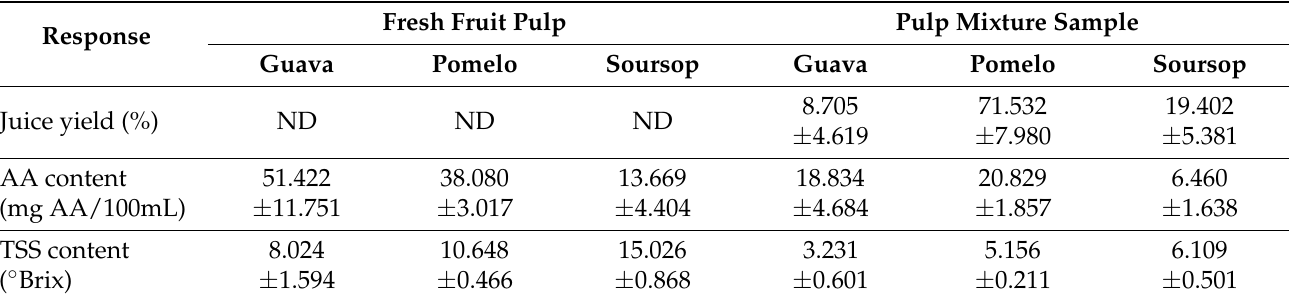
Table 2. Properties a of fresh fruit pulps and control mixtures.